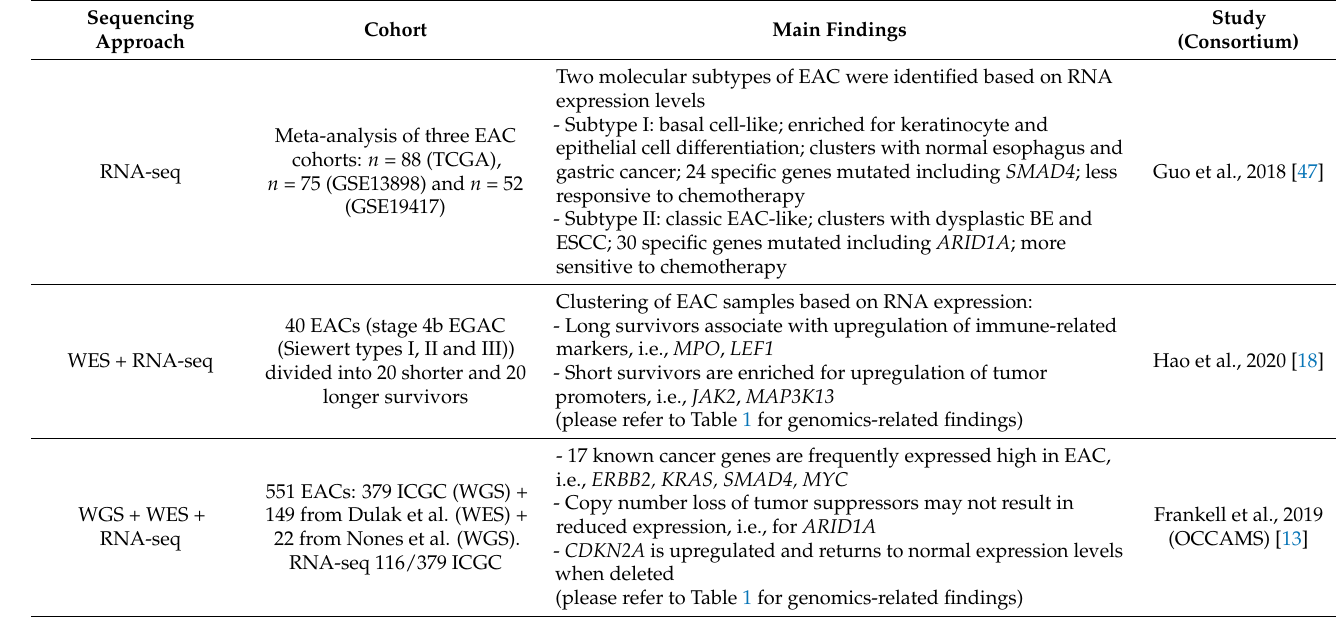
Table 2. Major transcriptomic findings in next-generation sequencing studies of EAC. Sequencing Cohort Main Approach